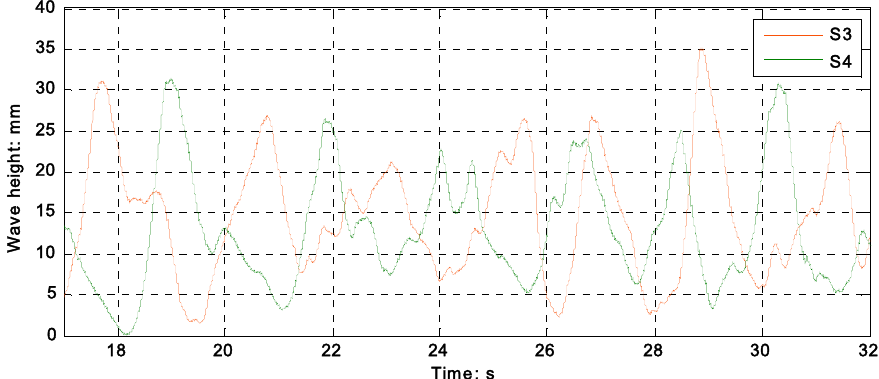
Figure 20. Wave curves when the significant wave height is 0.3 m and the average wave period is 3 s. (S3 is the wave curve before the ACWEC; S4 is the wave curve after the ACWEC.).